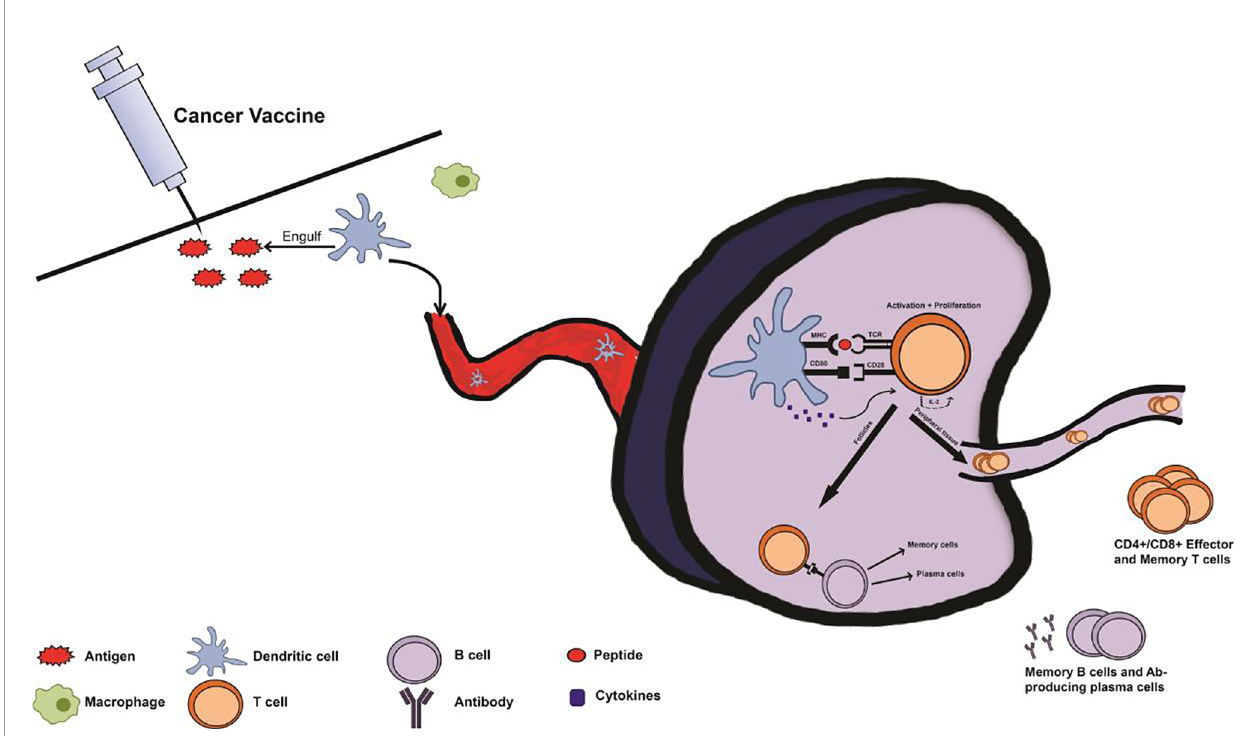
FIGURE 2 | Immune system response with prophylactic cancer vaccine administration. Following administration of a cancer vaccine, antigen-presenting cells (APCs) from the innate immune system such as macrophages and dendritic cells (DCs) recognize the injected antigen as foreign via pattern recognition receptors (PRRs), and uptake the antigen. Subsequently, the APCs transport the antigen, migrating to a lymph node and processing and presenting the antigen via major histocompatibility complex (MHC) pathway. Once in the lymph node, an immune synapse will form as the APC presents the antigen to an immature T cell at the T cell receptor (TCR). T cells will be activated by this interaction, with the aid of cytokines and co-stimulatory signals from the APC. Upon activation, T cells proliferate via IL-2 production and differentiate into effector T cells depending on cytokines and MHC type from the APC. These T cells can then contribute to the activation of B cells or travel to distant sites as effector or memory T cells. This primary response following vaccination produces memory cells so that secondary exposure to cancer-associated antigens results in a rapid and robust secondary immune